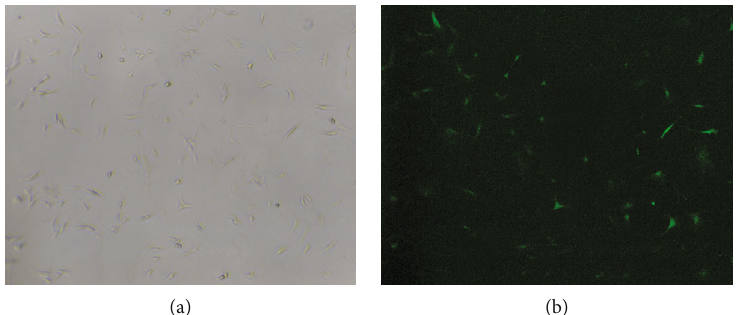
Figure 2: The transfection result. (a) The EPCs observed under a microscope in natural light (x100). (b) The positive cells with green fl uorescent protein (GFP) were observed by fl uorescence in the same fi eld and at the same magni fi cation.